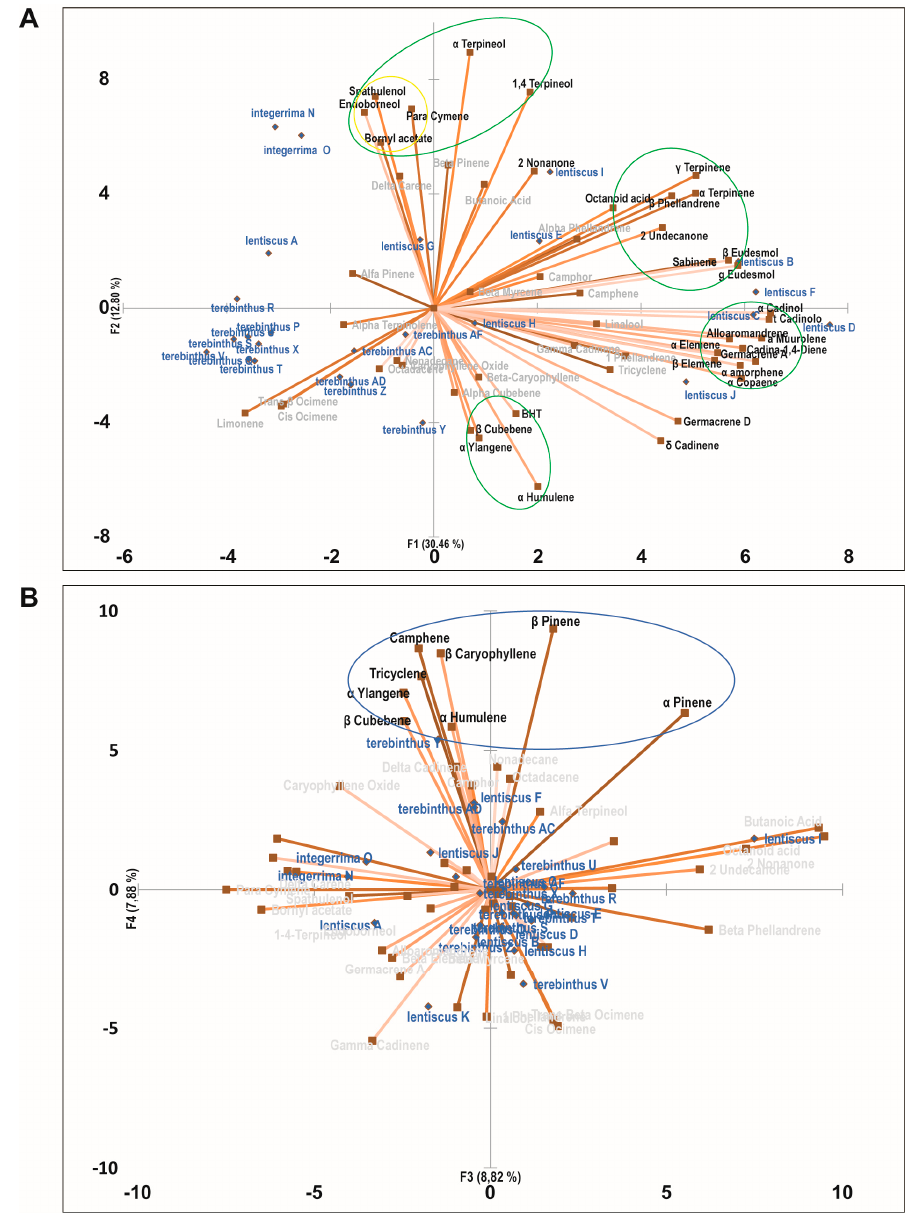
Figure 1. Principal Component Analysis of the cytotoxic effect of Pistacia essential oils on LoVo cells. ( A ) PCA biplot with PC1 and PC2 distribution of essential oil samples and chemical components of the phytocomplexes. ( B ) PCA biplot with PC3 and PC4 distribution of essential oil samples and chemical components of the phytocomplexes. Clusters of cooperating compounds with a positive correlation to one or two components are identified with circles (green for P. lentiscus , yellow for P. integerrima , and blue for P. terebinthus ).